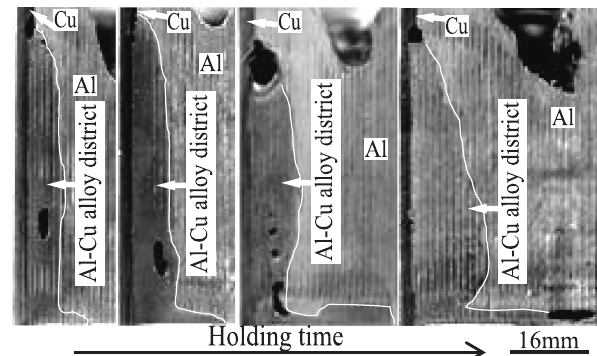
Figure 3: Recombination effects of Cu and Al at 830°C pouring under vertical pouring.